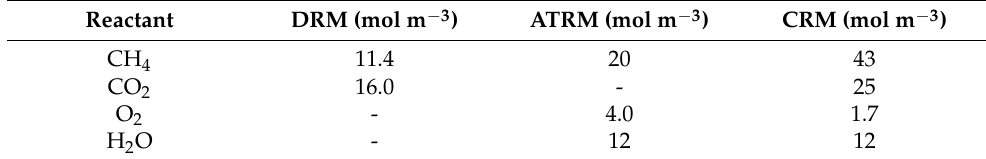
Table 5. Composition of the reactor feed in the operation of the reform processes.